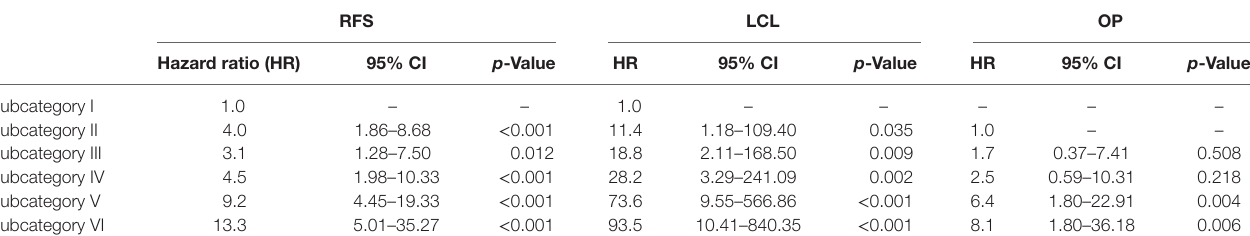
Table 2 | Cox analysis between subcategories of recurrence-free survival (RFS), local control with laser alone (LCL), and organ preservation (OP).